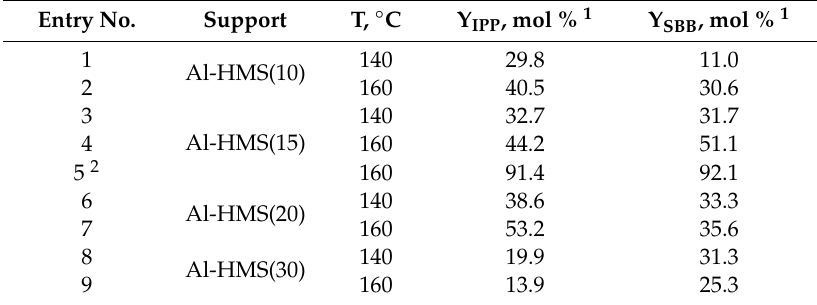
Table 4. The hydrogenolysis of TMD and ETMD over 2% wt. Pd/Al-HMS catalysts with the different supports. The conditions are: p(H 2 ) = 40 bar, 100 mg of the catalyst, 2.5 ml of the ketal, the reaction time 5 h. Entry No.